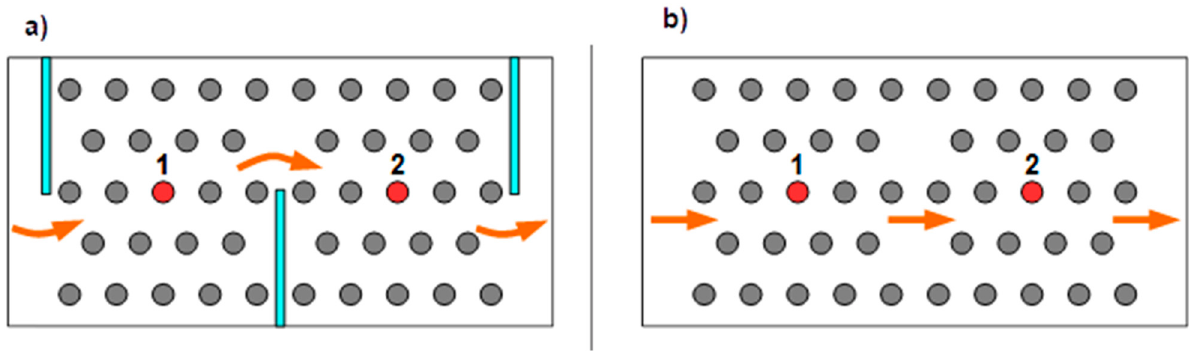
Figure 8. TRINI flow configurations: ( a ) With and ( b ) Without baffles. Both heating tubes (red, numbered 1 and 2) are active at the same time.